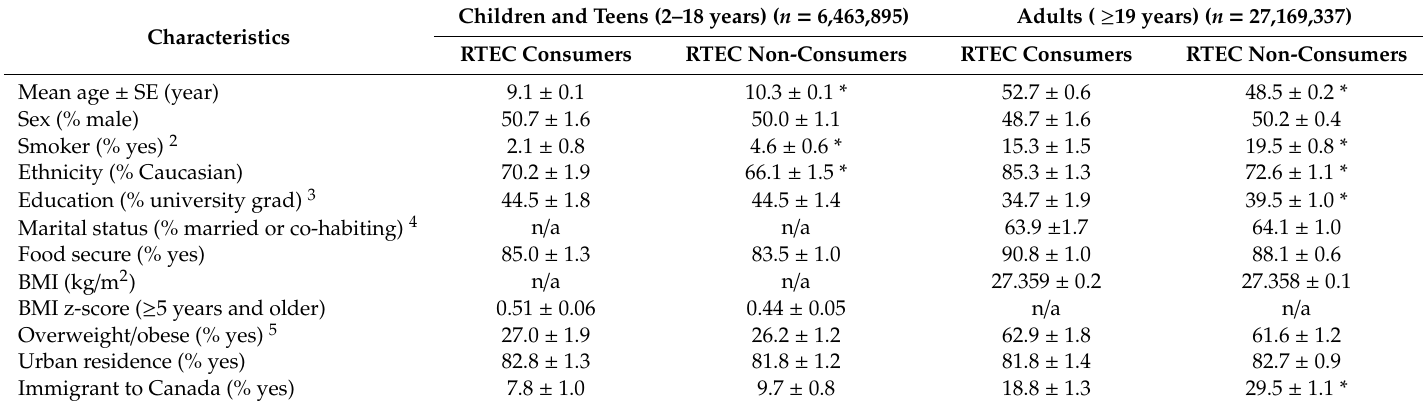
Table 1. Sociodemographic Characteristics of Canadian Children and Adults among Ready-to-Eat Cereal (RTEC) Consumers and Non-Consumers 1 .